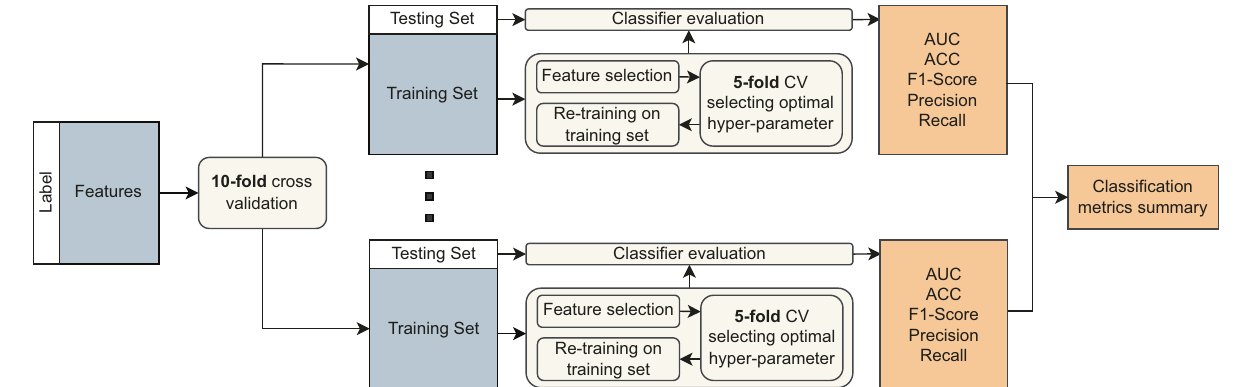
Fig. 2 The nested cross validation (CV). The inner CV was to tune the hyperparameters, and the outer CV was to select the discriminative features and evaluate the performance of models.